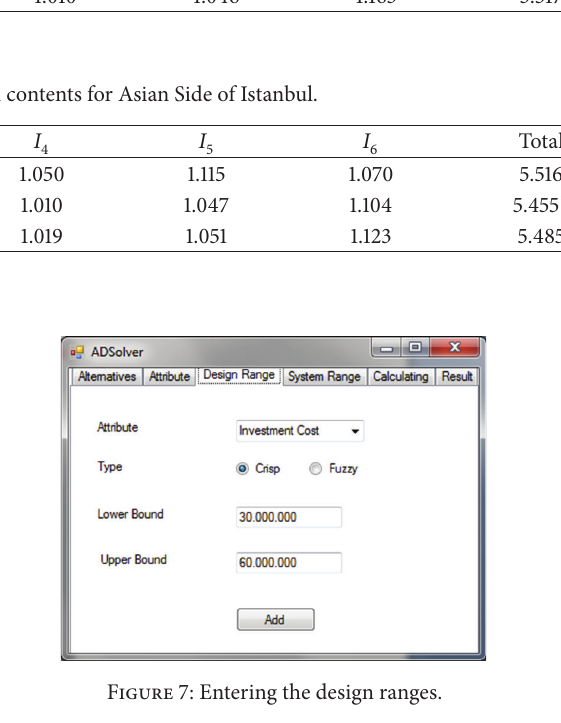
Figure 6: Entering the main and subcriteria.